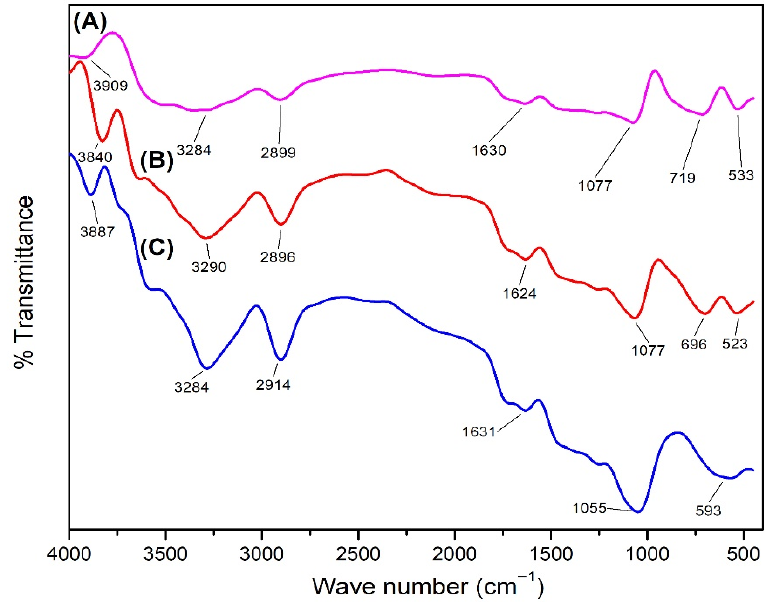
Figure 12. FTIR spectrum on ( A ) impregnated mangium wood with 5% TiO 2 nanoparticle, ( B ) impregnated mangium wood with 1% TiO 2 nanoparticle, ( C ) untreated mangium wood.